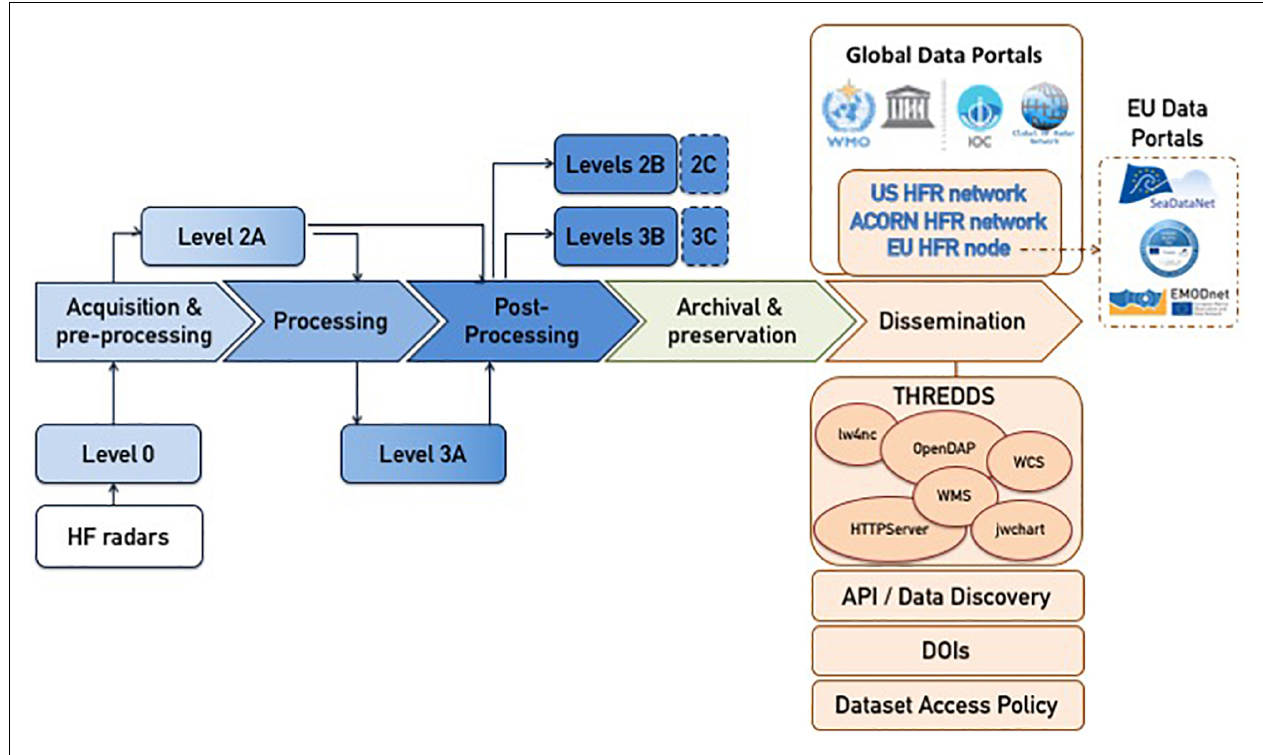
FIGURE 3 | Data life cycle of HF radar data from acquisition to